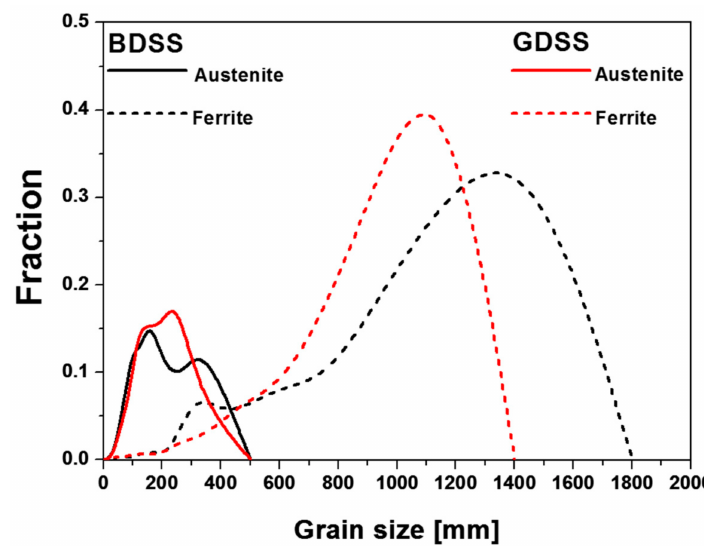
Figure 2. The grain size distributions of as-cast SDSSs for each phase characterized by electron backscatter diffraction (EBSD).